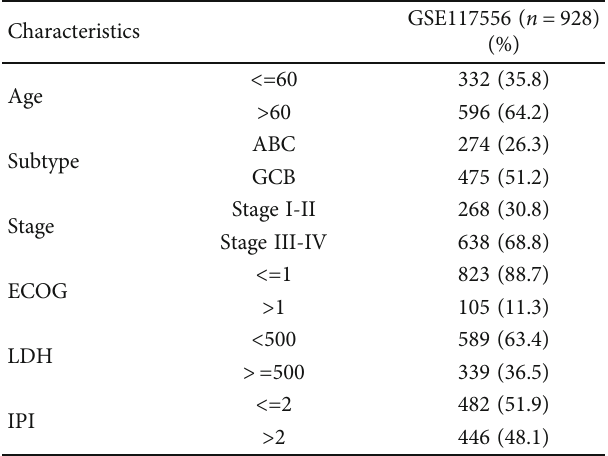
Table 1: Dataset related